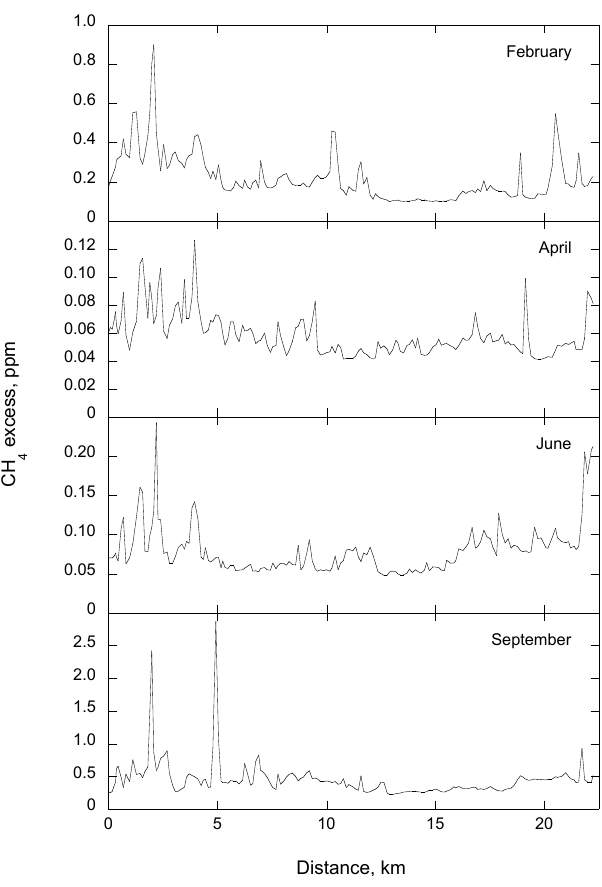
Figure 9. The CH 4 mole fraction along a road transect in Los An- geles, California, USA. The same transect was repeated over both morning and evening time periods for all four seasons of the year. The distance from the origin ( x axis) represents the distance trav- eled along the road, and methane mole fraction ( y axis) represents the average mole fraction above background for combined morning and evening time periods within each seasonal time period.